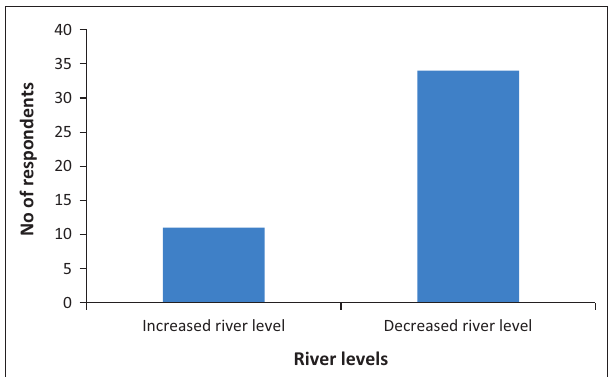
FIGURE 2: Responses on observed river